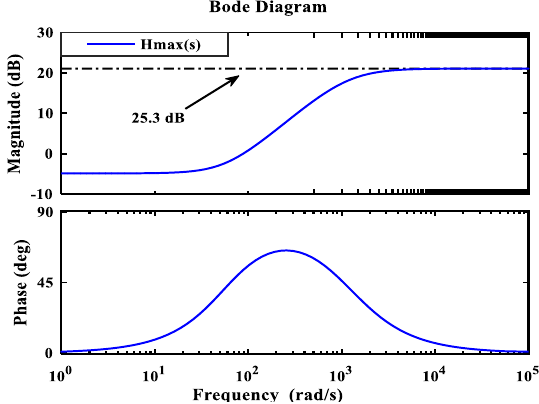
H s ( ) . H s ( ) . max max